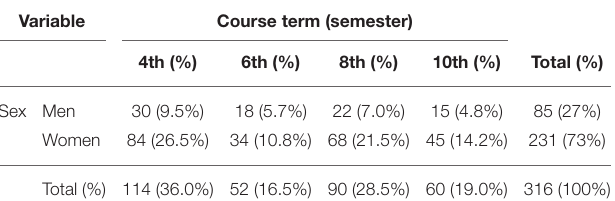
TABLE 2 | Items of the scale of teaching performance of the psychology professor